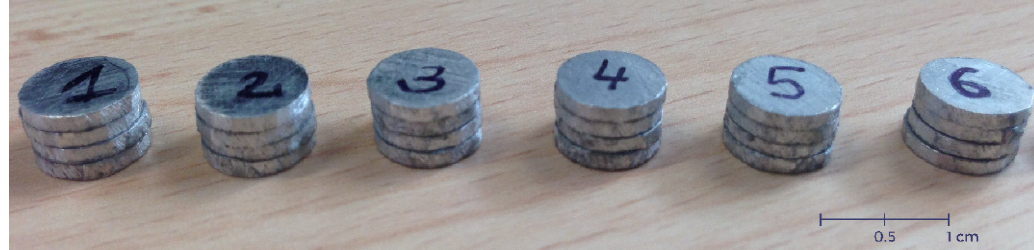
Figure 5. Split Hokinson pressure bar (SHPB) specimen’s built using four disks cut from the aluminum sheet of 1 mm thickness. sheet of 1 mm thickness.